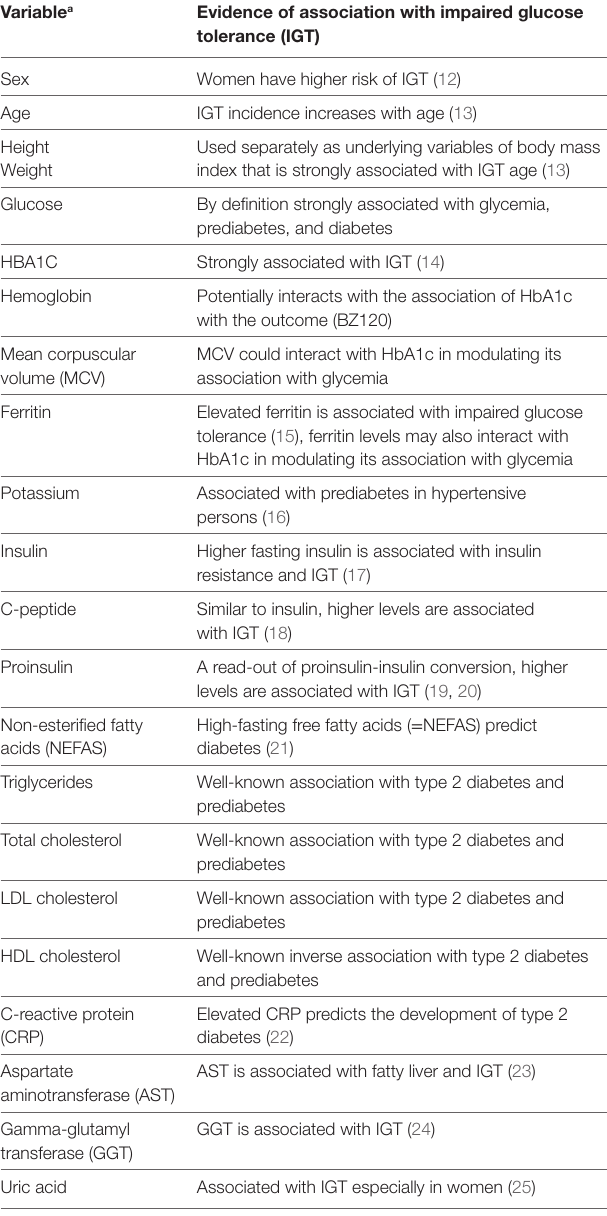
Table 1 | List of anthropometric, clinical, and laboratory variables used as features in the machine learning